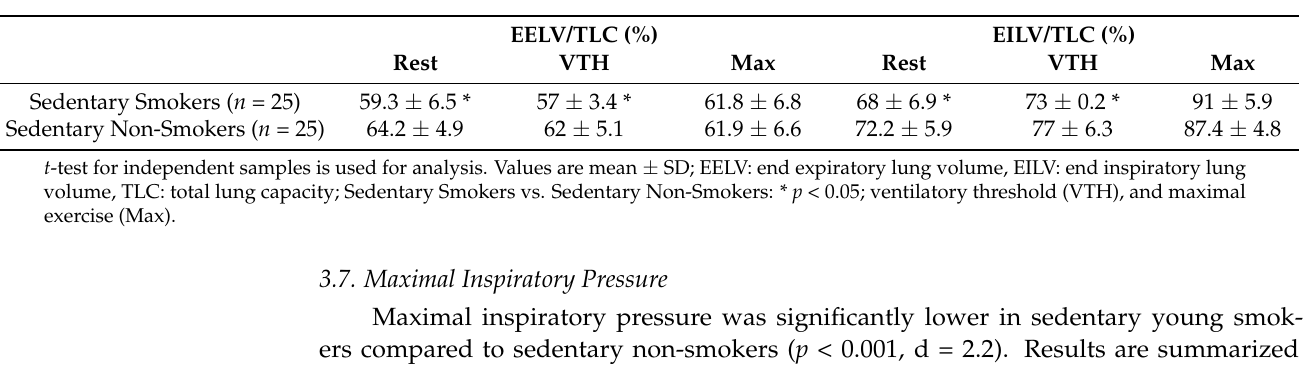
Figure 4. Tidal volume V T (squares) and breathing frequency f (circles) plotted against minute ventilation. t -test for independent samples is used for analysis. Data represented at rest, first minute of exercise, ventilatory threshold, and maximal exercise, respectively; Sedentary smokers vs. sedentary non-smokers: * p < 0.05; ** p < 0.01; *** p < 0.001. EILV (% TLC) was significantly lower in sedentary young smokers at rest and at VT ( p < 0.05, d = 0.82) but not during peak exercise. EELV (%TLC) and EILV (%TLC) kinetics are shown in Table 4. Table 4. End of Expiratory and Inspiratory lung volumes as percentage of Total Lung Capacity (TLC) in sedentary smokers and controls during